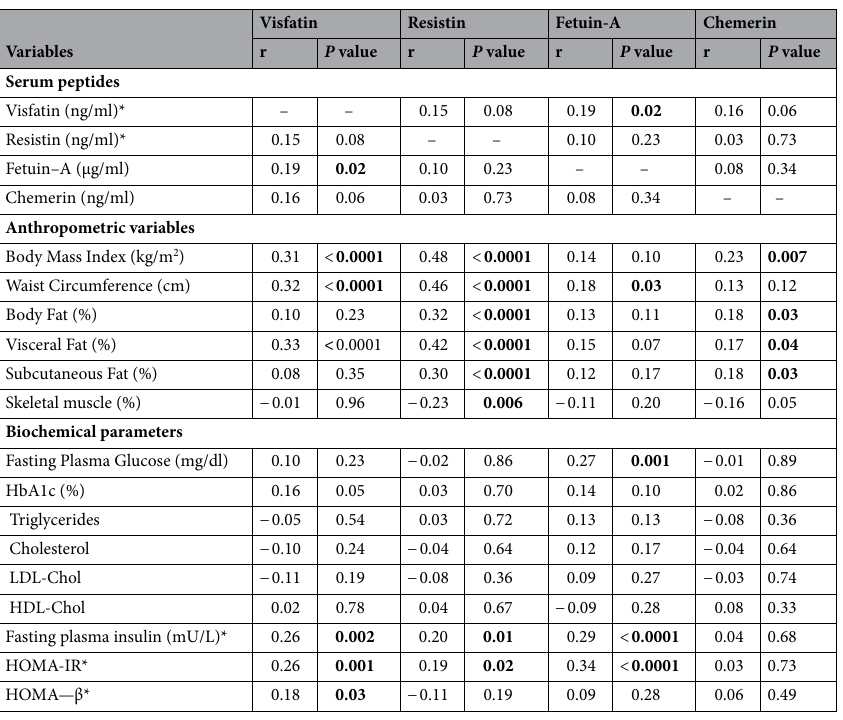
Table 2. Correlation of Visfatin, Resistin, Fetuin-A and Chemerin with other variables studied. *Median values are log transformed. Values shown are correlation coefficients (r). Correlation is considered significant at p < 0.05 and the respective values are in bold. HbA1c glycosylated haemoglobin, LDL-Chol low density lipid cholesterol, HDL-Chol high density lipid cholesterol, HOMA-IR homeostatic model assessment of insulin resistance, HOMA β homeostatic model assessment of β-cell